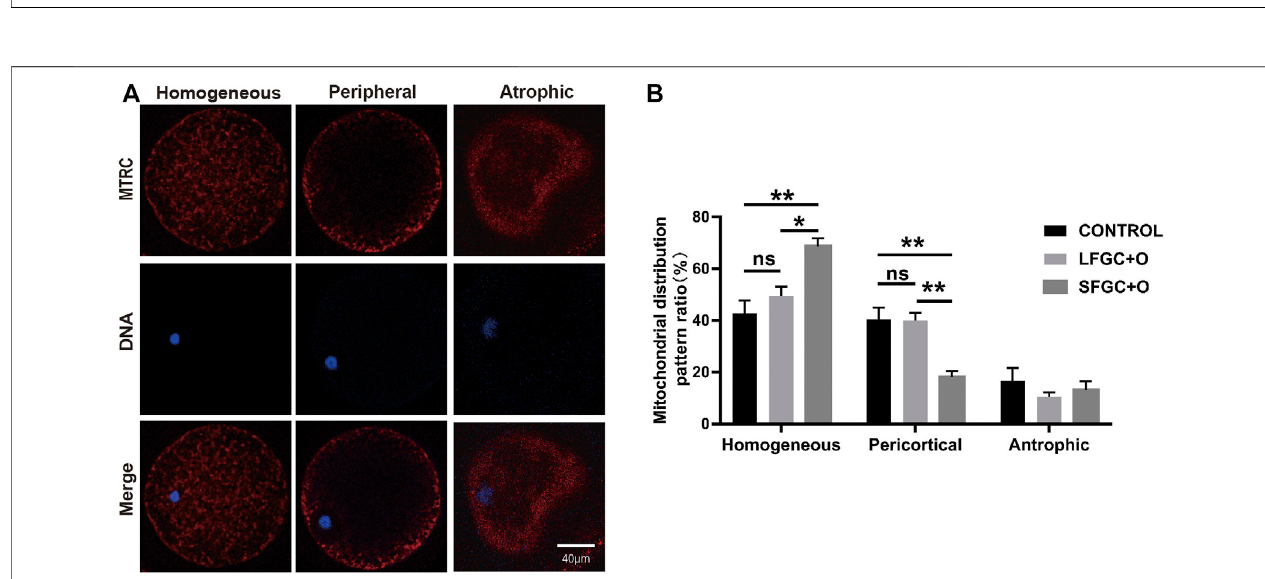
FIGURE 3 | Effects of GC co-culture on mitochondrial distributions in mare MII oocytes. (A) Mitochondria stained with MitoTracker Red in mare MII oocytes after in vitro maturation were detected using confocal microscopy. Scale bar = 20 µm. (B) Percentages of homogeneous, peripheral, and atrophic distributions of mitochondria in mare MII oocytes derived from the CONTROL, LFGC-O, and SFGC-O groups (76 oocytes per group). Data are shown as means ± SEM. * p < 0.05 and ** p < 0.01.